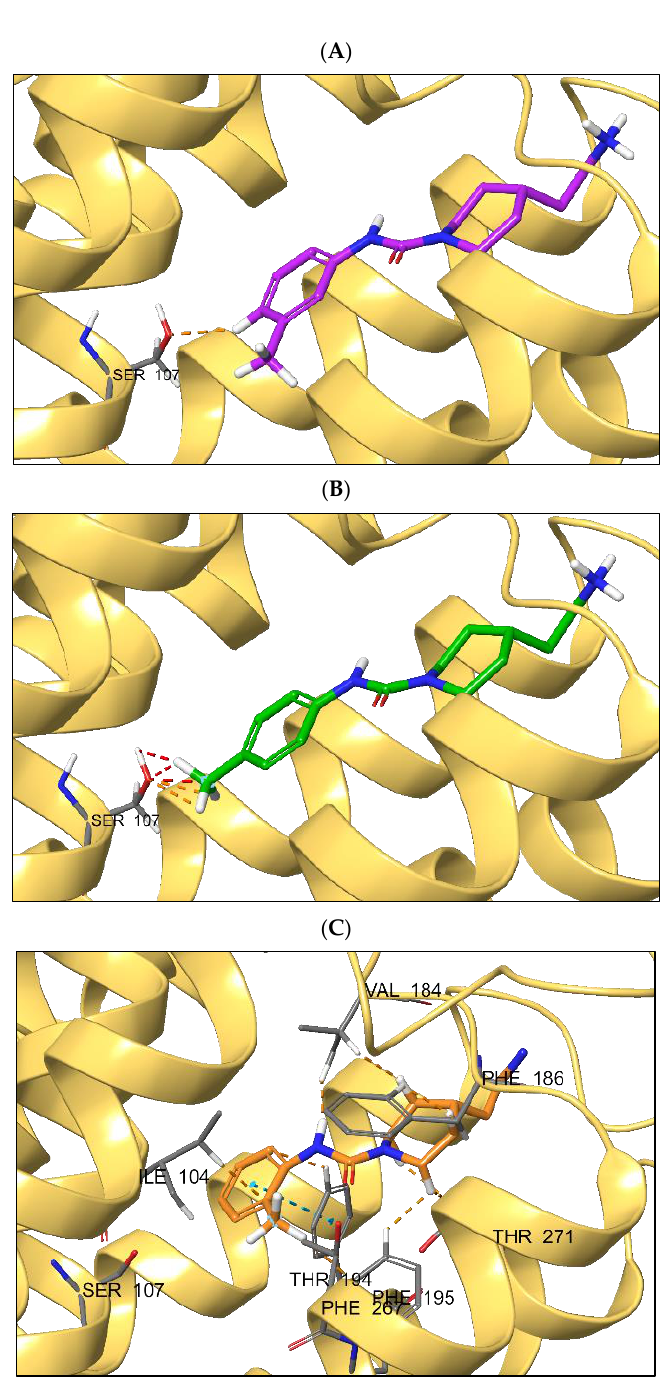
Figure 4. ( A ) Unconstrained docking pose of compound 9 ; ( B ) forcibly docked compound 7 with the clash with Ser107 residue; ( C ) forcibly docked compound 10 with a network of unfavorable clashes. Dashed lines of orange and red color — strained protein – ligand contacts (clashes).